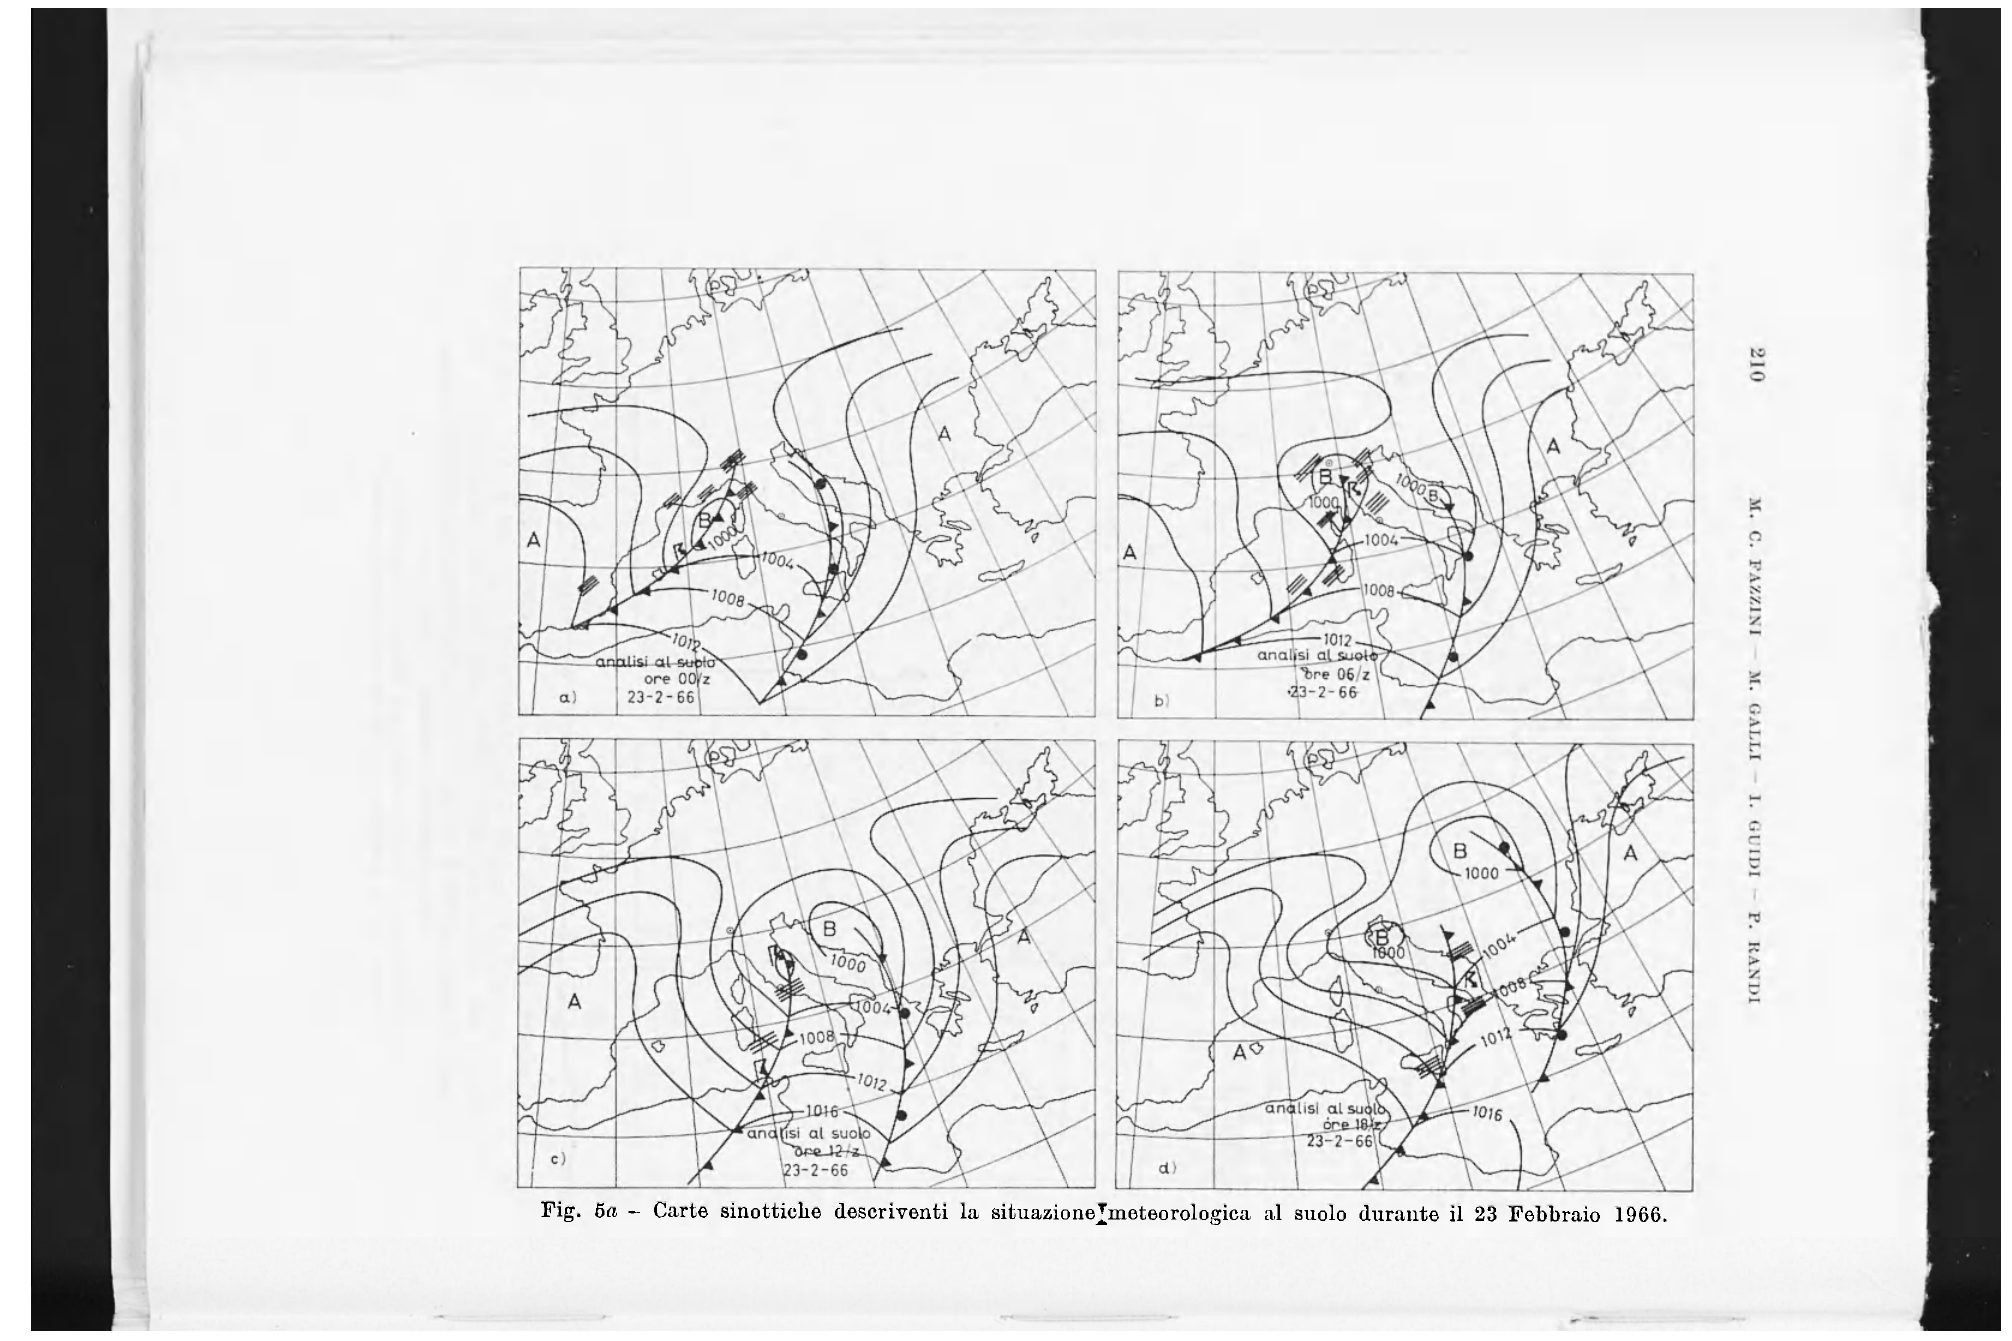
Fig. 5a - Carte sinottiche descriventi la situazionejmeteorologica al suolo durante il 23 Febbraio